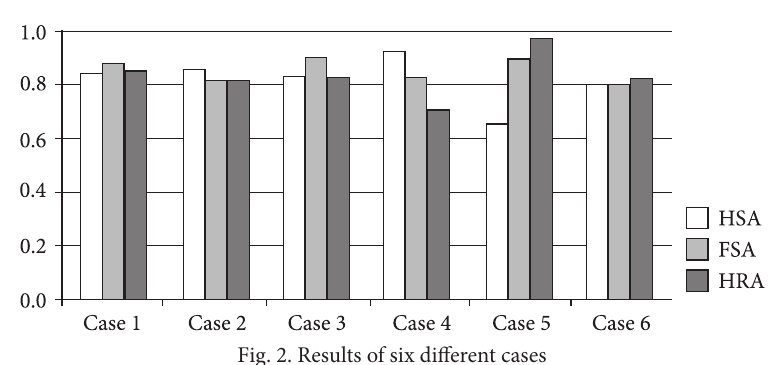
Fig. 2. Results of six different